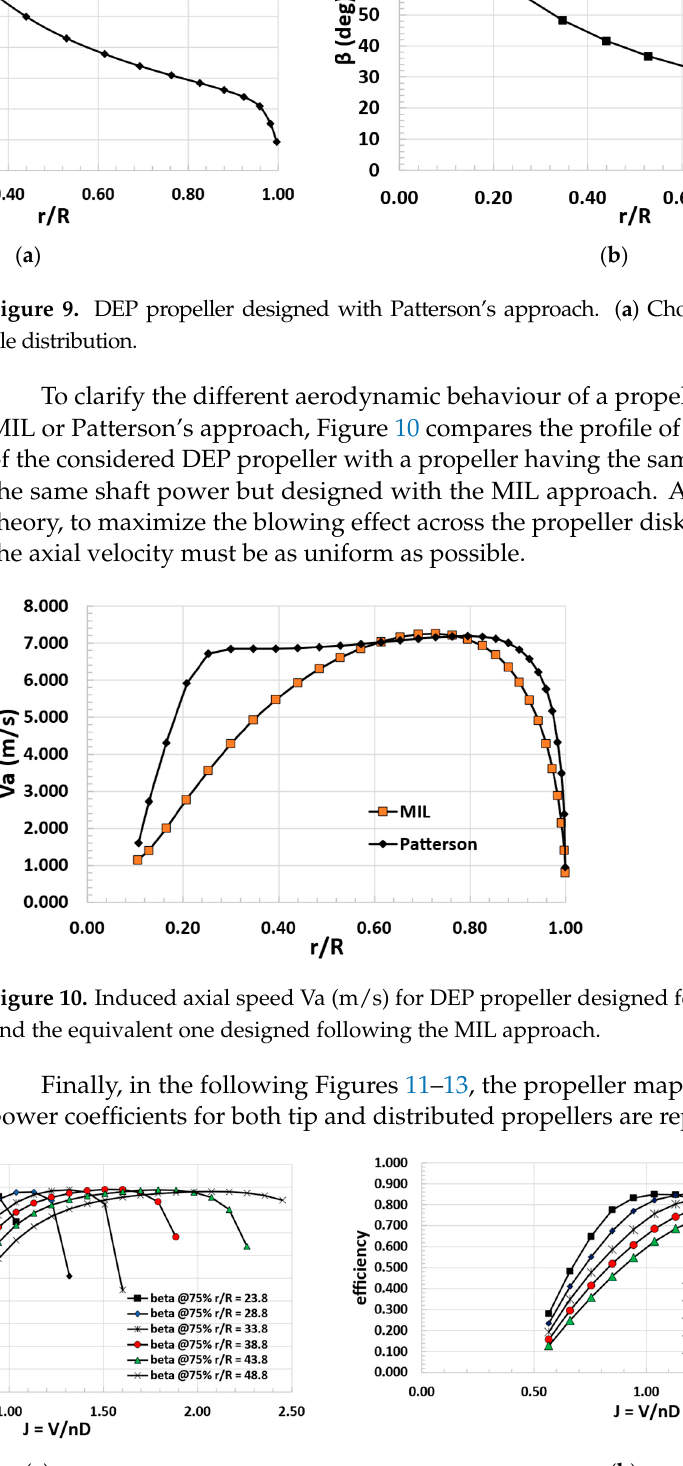
Table 8. Propellers take-off operating points. Both DEP and TIP propellers have a right-handed rotation.